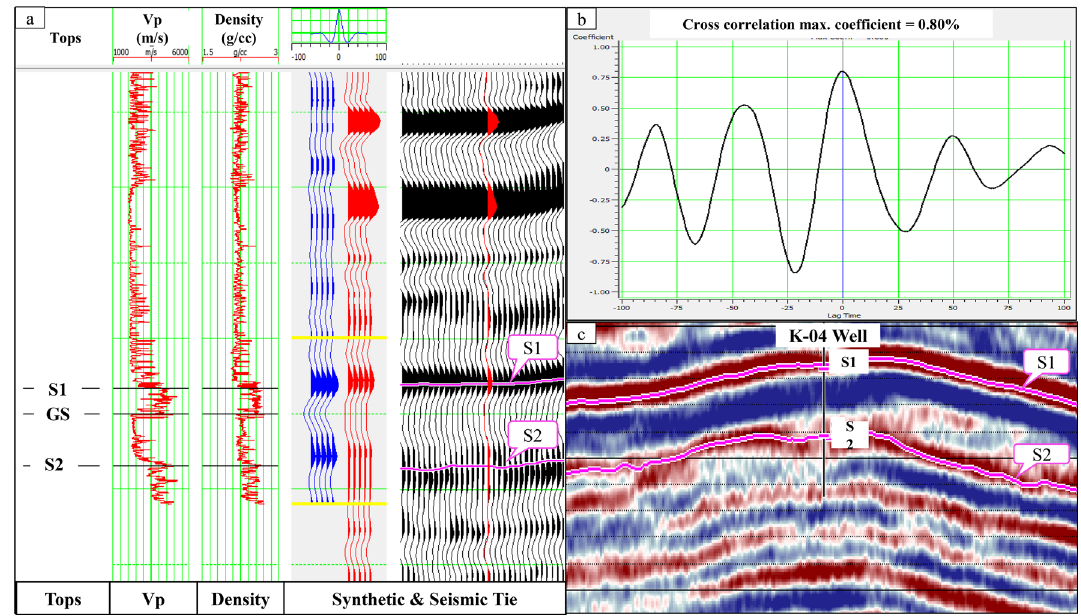
Fig. 10 a Blue trace beside the p -wave seismic (red trace) is the syn- thetic zero offset p -wave response calculated from logs (Vp and den- sity) information extracted along the well bore, b estimated determin-